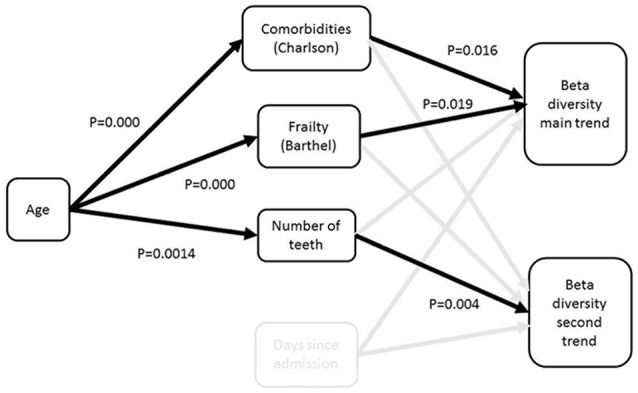
Path diagram for best fit structural equation model. The model demonstrates that the major trend in beta diversity is related to the extent of frailty and comorbidities, which are both related to age; the second trend is related to the number of teeth. There was no impact of time since admission on the trends in beta diversity.